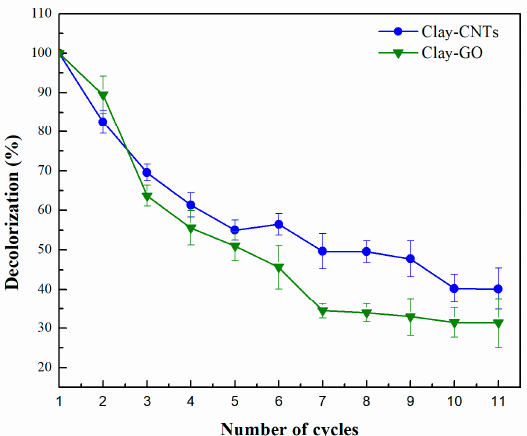
Figure 3. Reusability of covalently immobilized TvL on hybrid nanomaterials for the decolorization of methyl orange.